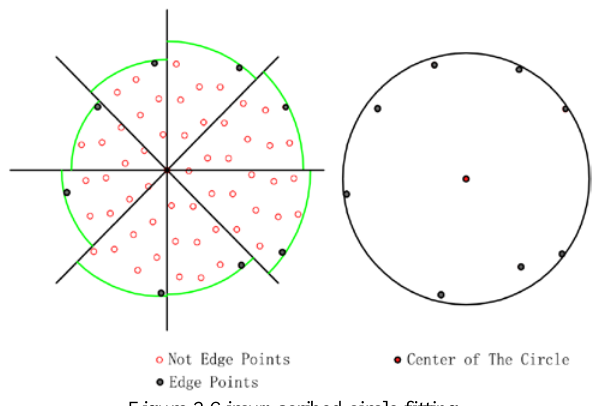
Figure 2 Circumscribed circle